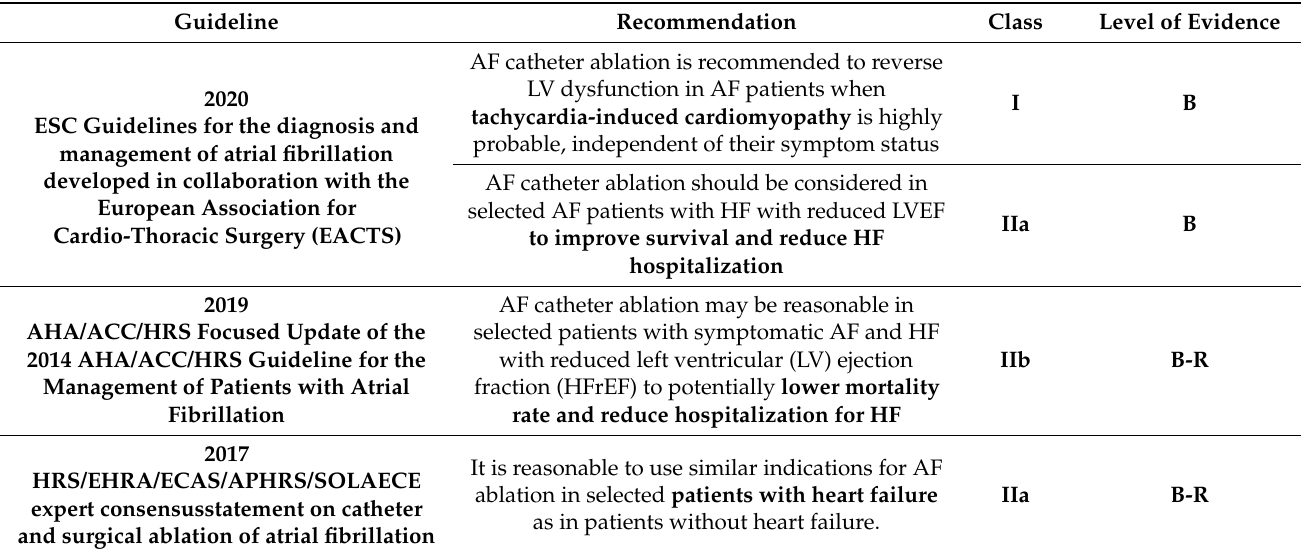
Table 1. Summary of current guidelines/recommendations on catheter ablation in patients with